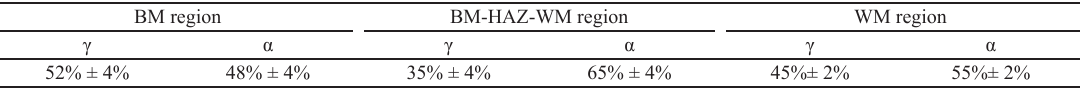
Figure 4. Optical micrograph of the surface top etched with modified Behara for 600 s in the: a. BM, b. HAZ, and c. WM. d-f. Binary images corresponding to the images a-c. Table 2. Percentage of austenite and ferrite phases in BM, BM-HAZ-WM, and WM determined at the top of the DSS UNS S32205 welded samples. BM